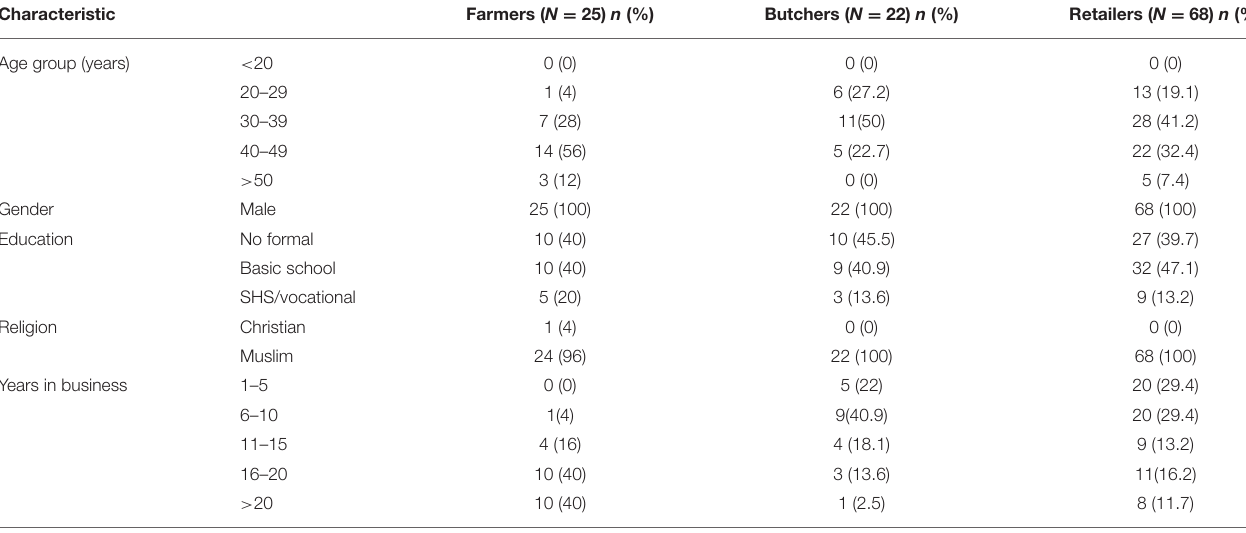
TABLE 1 | Demographic characteristics of farmers, butchers and retailers along beef value chain in Ashaiman Municipal area. Characteristic